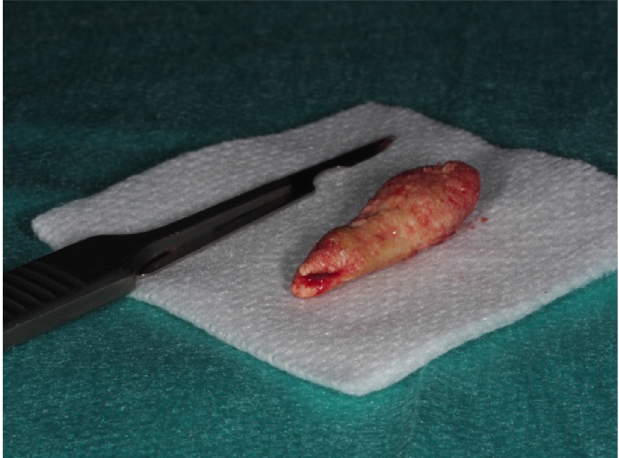
Fig. 3. Clinical view of an elongated calculus.